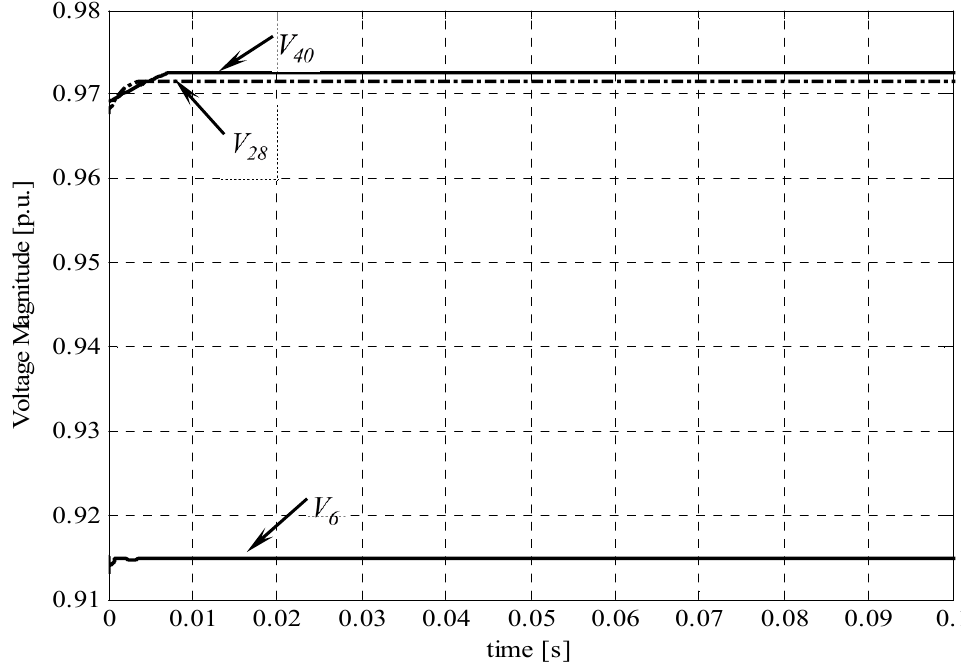
Figure 5. Time domain behavior of the voltage at the selected control buses.